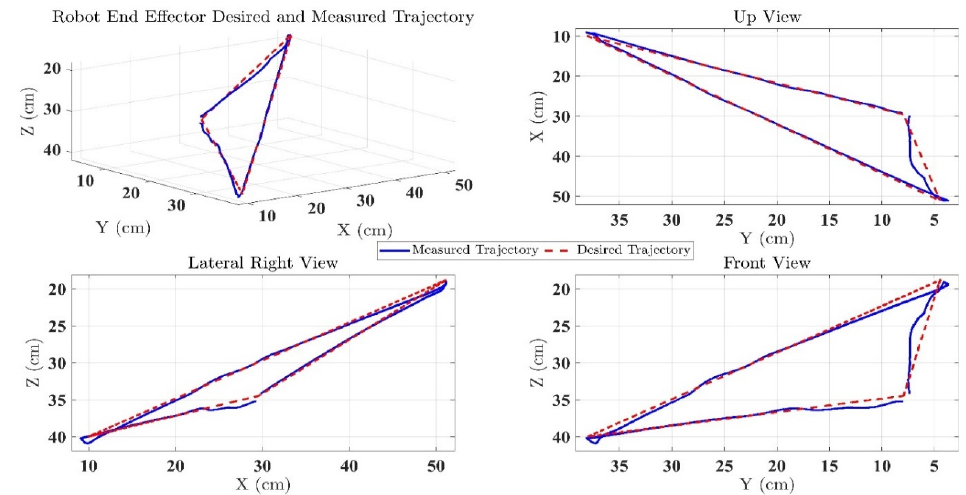
Figure 9. SREx trajectory tracking performance in Cartesian space under the conventional super-twisting controller.